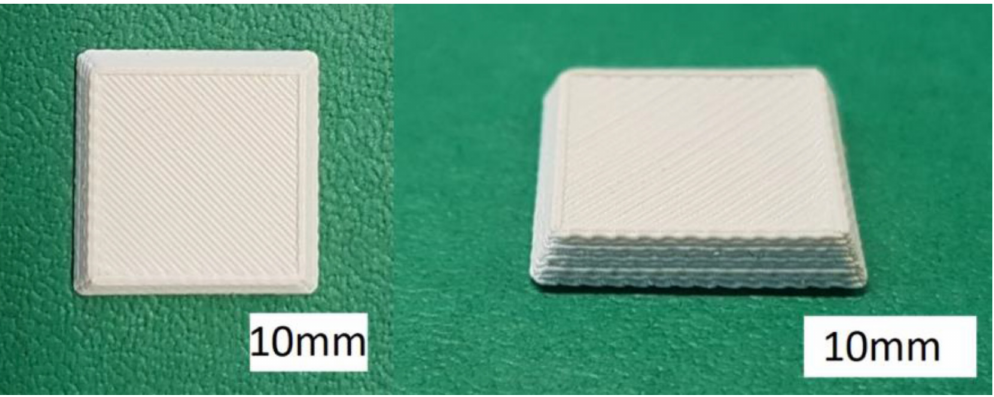
Figure 16. Green zirconia test components with 5 vol.-% polysaccharide (PS) as a PFA; ( left ) top view, ( right ) angled view.